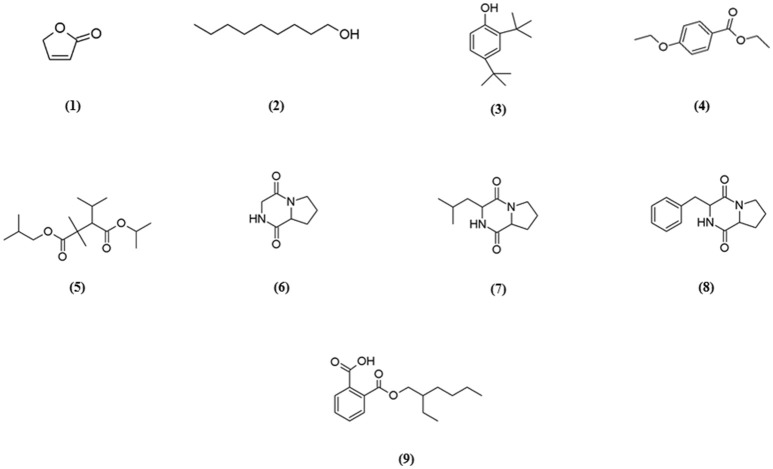
Chemical structures of constituents detected in MUSC 93JT extract.